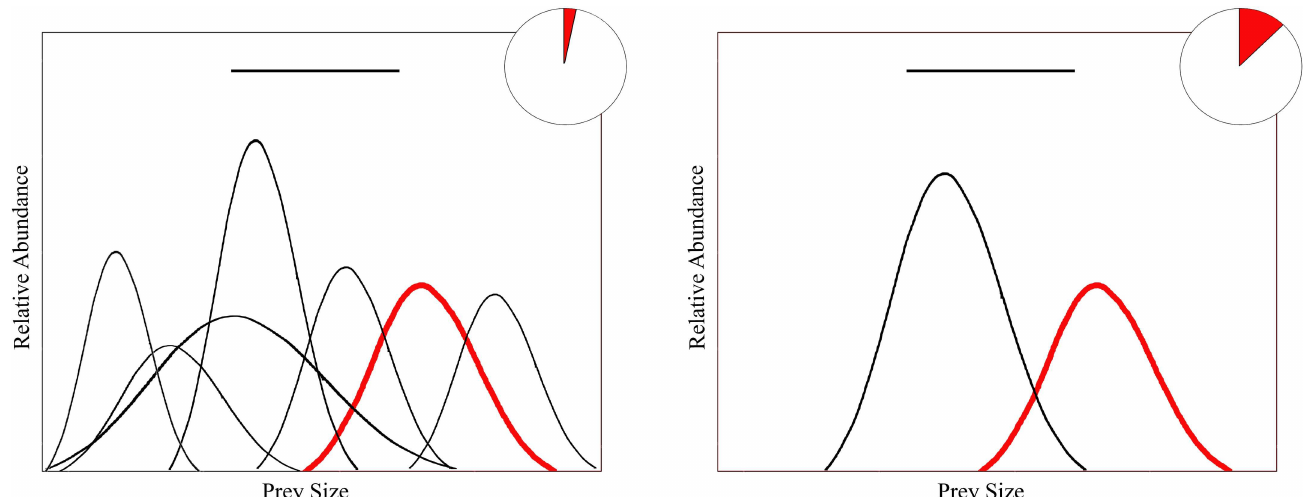
Fig 1. Predicted influence of prey species diversity on probability of prey encounter rates and cannibalism. In a species-rich assemblage(A), low relative abundance of conspecificprey (red curves) results in low rates of encounter with conspecifics relativeto heterospecific prey (black curves) and a low rate of cannibalism. In a species-poor assemblage(B), conspecificprey comprise a greater percentage of available prey, and encounter rates with conspecifics and cannibalismwould be higher. Curves represent size frequencydistributionsof various prey. Heavy black horizontalline represents the range of prey sizes consumedby the predator. Pie charts represent dietary proportions of conspecific(red area) and heterospecific prey (white area).